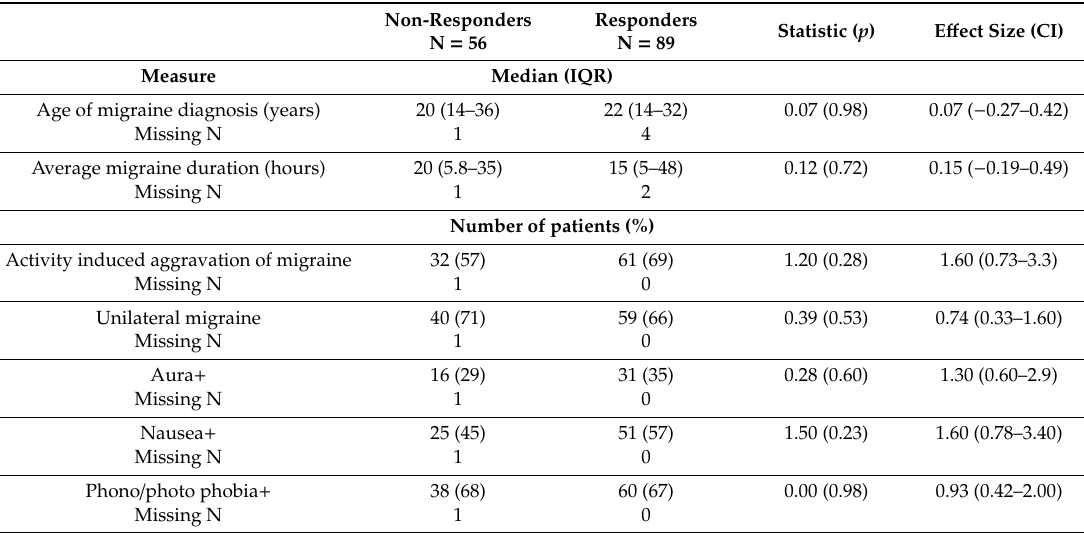
Table 2. Migraine